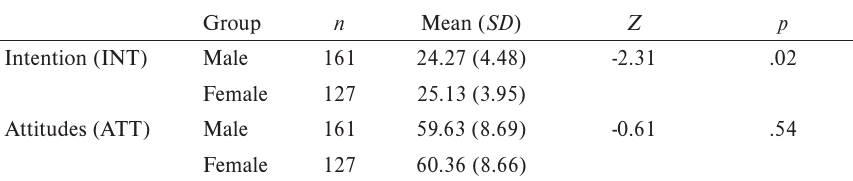
Attitudes towards inclusion between male and female participants